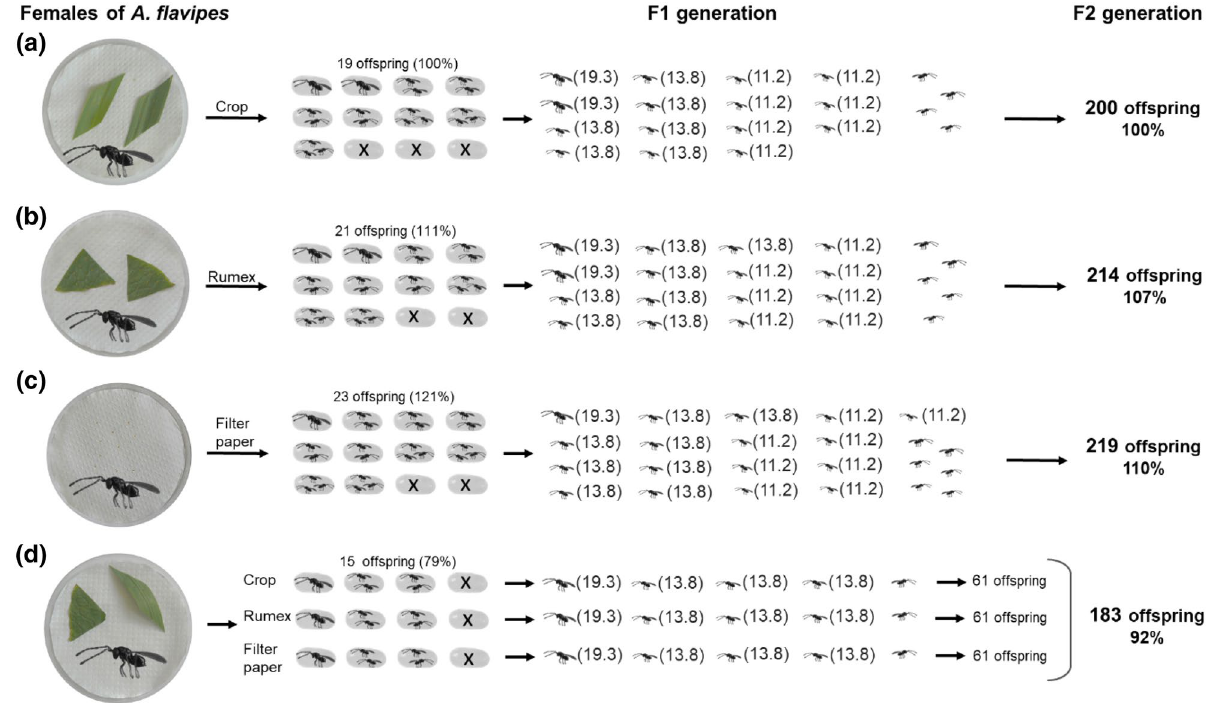
Figure 4. The relationship between different fitness characteristics in F1 generation and fertility in F2 generation for four groups of females with different type of substrate on which the host eggs were offered; the 12 host eggs were offered on the (1) Non-choice test: ( a ) usual host plant (crop); ( b ) fictitious host plant ( Rumex ); ( c ) control substrate (filter paper) and (2) Choice test: ( d ) combination on all (usual, fictitious host plant and control substrate). (*The fertility values (shown in parentheses); To simplify the model the male offspring are not